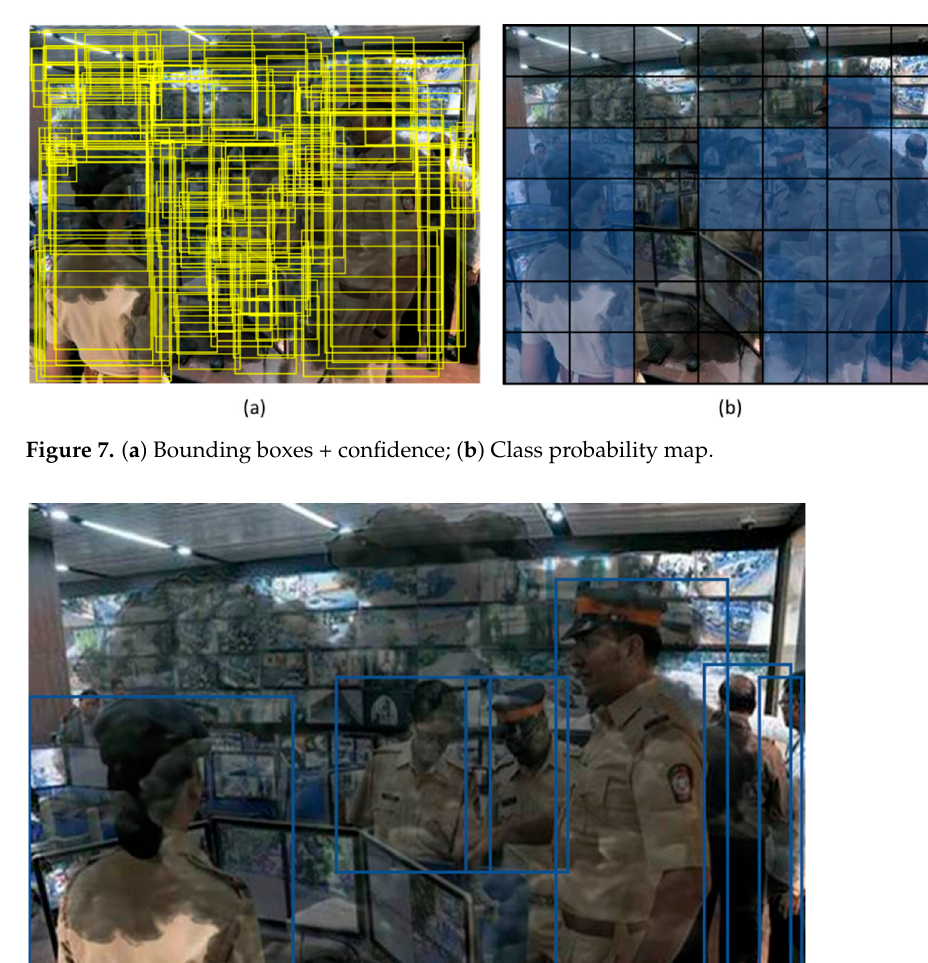
Figure 6. Images showing varying smoke concentration.